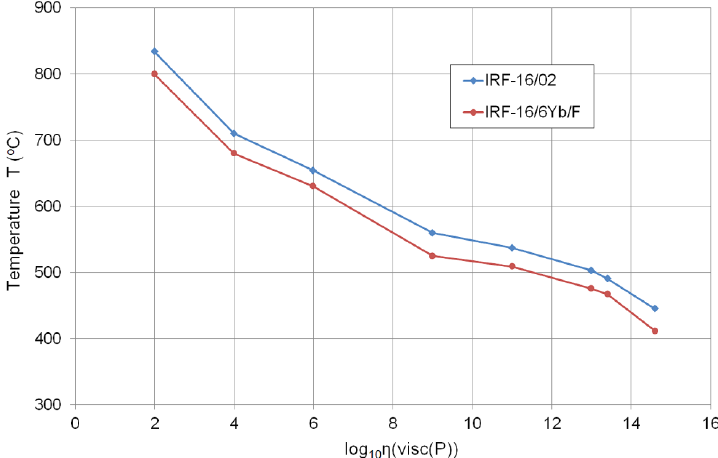
Figure 4. Viscosity characteristics of two finally matched glasses (melting volumes of 1500 g and 800